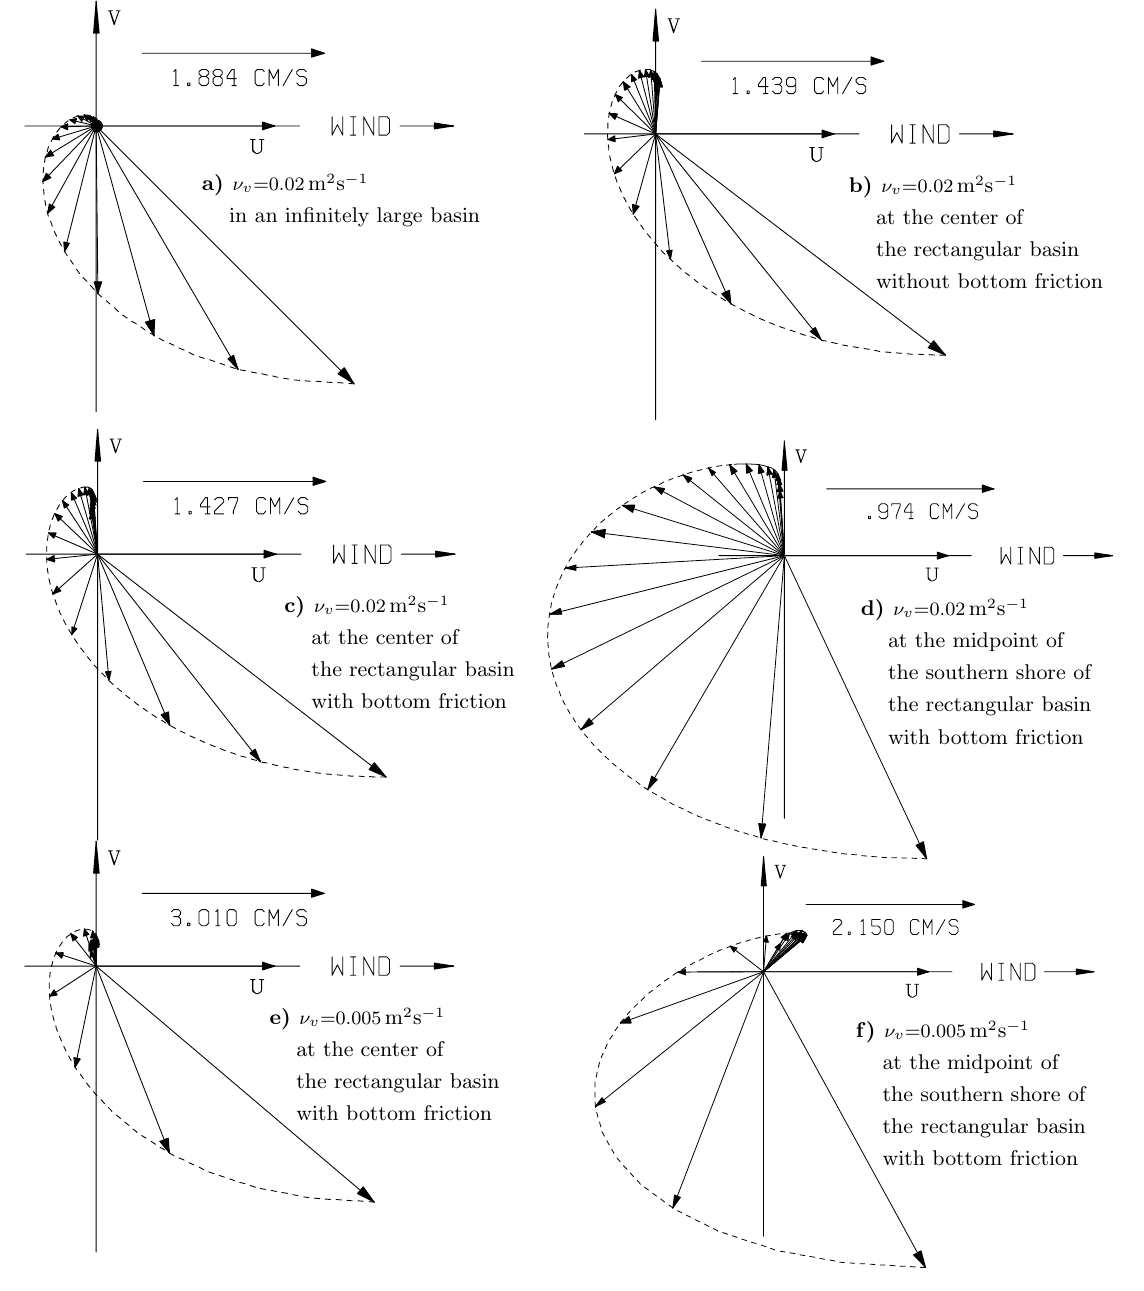
Fig. 5. Ekman spirals in an infinite ocean (a) and in a rectangular basin with 65km × 17km side lengths and 100 m depth (b-f) , respectively. FIG. 5: Ekman spirals in an infinite ocean (a) and in a rectangular basin with 65 km × 17 km side lengths The graphs show the horizontal velocities in a vertical profile at the indicated positions. The drawn arrows are for positions 5 m apart from and 100 m depth (b-f), respectively. The graphs show the horizontal velocities in a vertical profile at the one another, from the free surface to the bottom. (a) in an infinite ocean with ν v = 0 . 02m 2 s − 1 ; (b) at the midlake position of the rectangular indicated positions. The drawn arrows are for positions 5 m apart from one another from the free surface basin with ν v = 0 . 02m 2 s − 1 , no bottom friction; (c) at the midlake position and (d) near the southern shore with ν v = 0 . 02m 2 s − 1 and to the bottom. a) in an infinite ocean with ν v = 0 . 02 m 2 s − 1 ; b) at the midlake position of the rectangular bottom friction; (e) at the midlake position and (f) near the southern shore with ν v = 0 . 005m 2 s − 1 and bottom friction. Note the different scales used in each basin with ν v = 0 . 02 m 2 s − 1 , no bottom friction; c) at the midlake position and d) near the southern shore with ν v = 0 . 02 m 2 s − 1 and bottom friction; e) at the midlake position and f) near the southern shore with ν v = 0 . 005 m 2 s − 1 and bottom friction. Note the different scales used in each graph.